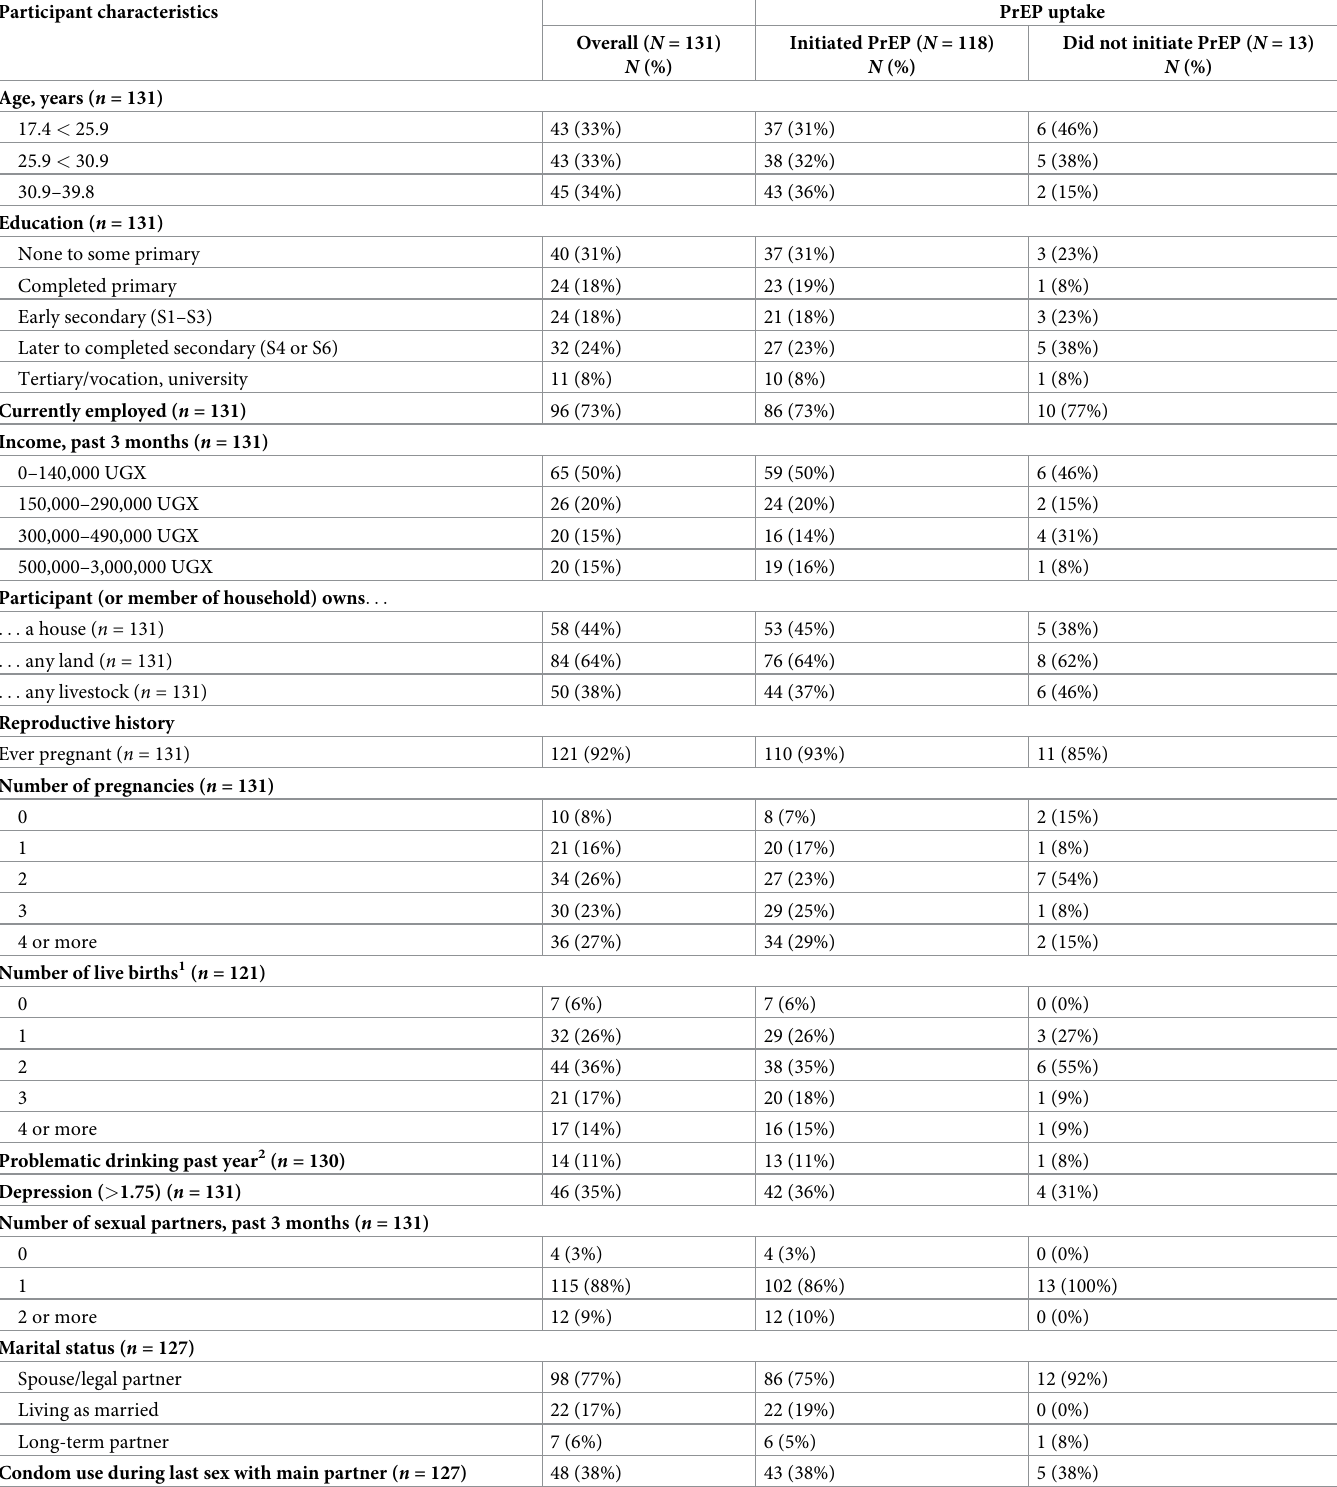
Table 1. Baseline characteristics of N = 131 participants in the Uganda Healthy Family Study, overall and according to PrEP